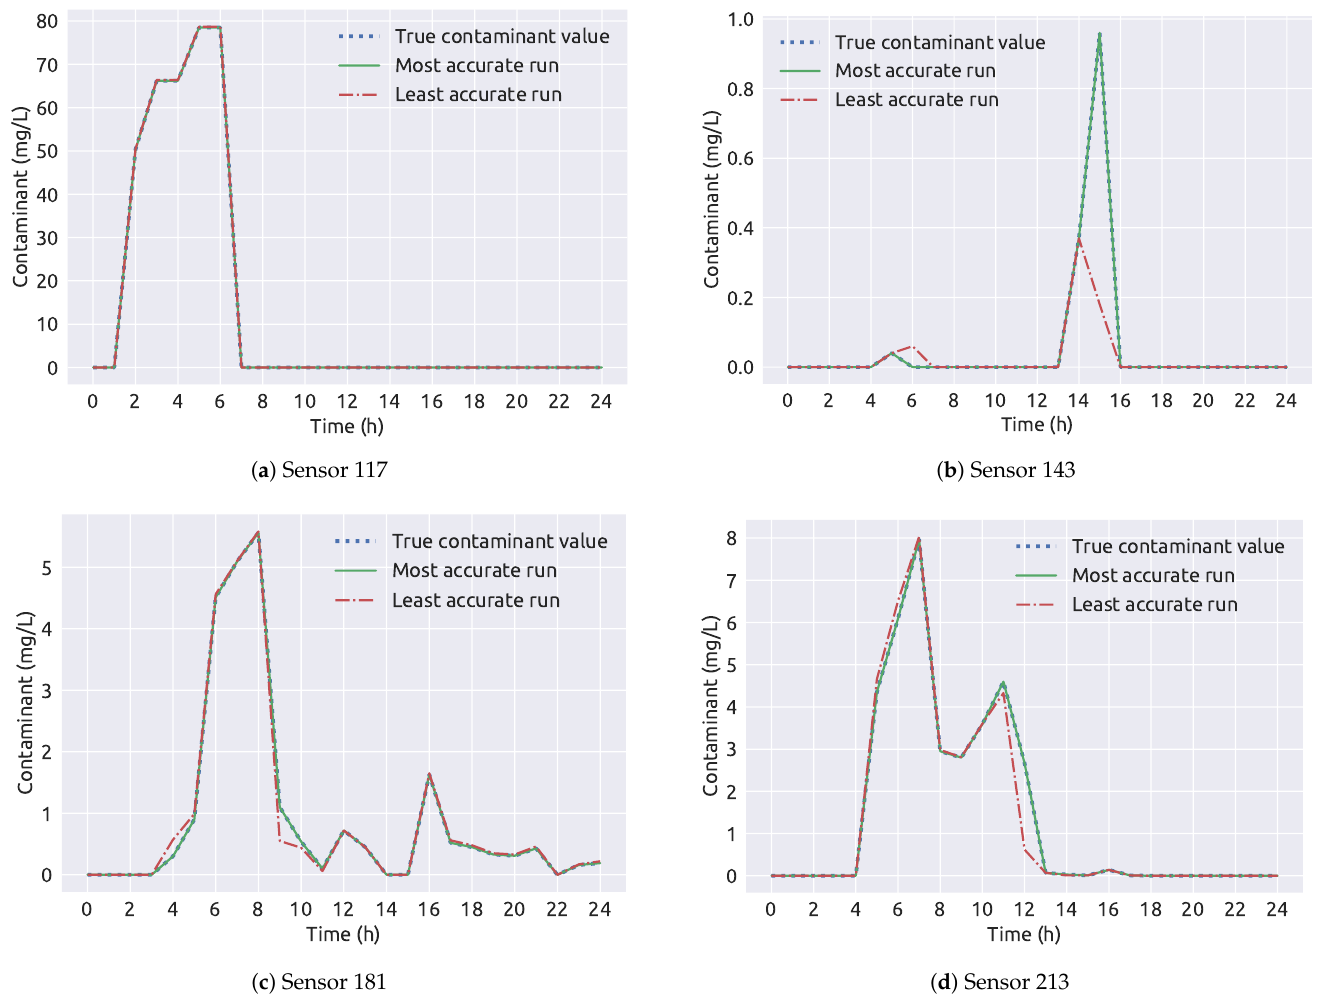
Figure 9. A comparison of sensor measurements through time for the NET3 benchmark network (framework 1). The Richmond water distribution network contamination event parameters (start, end times and injected contaminant concentration with the network source node) can be seen in Table 5. The coupling framework 1 was also repeatedly run 100 times for the Richmond network with the fuzzy sensor measurements. The average contaminant mass flow at the true source node 251 can be seen in Figure 10 and the maximum percentage of contamination mass over the simulation time is 0.0938% for this benchmark network case. Table 5. Richmond network contamination event